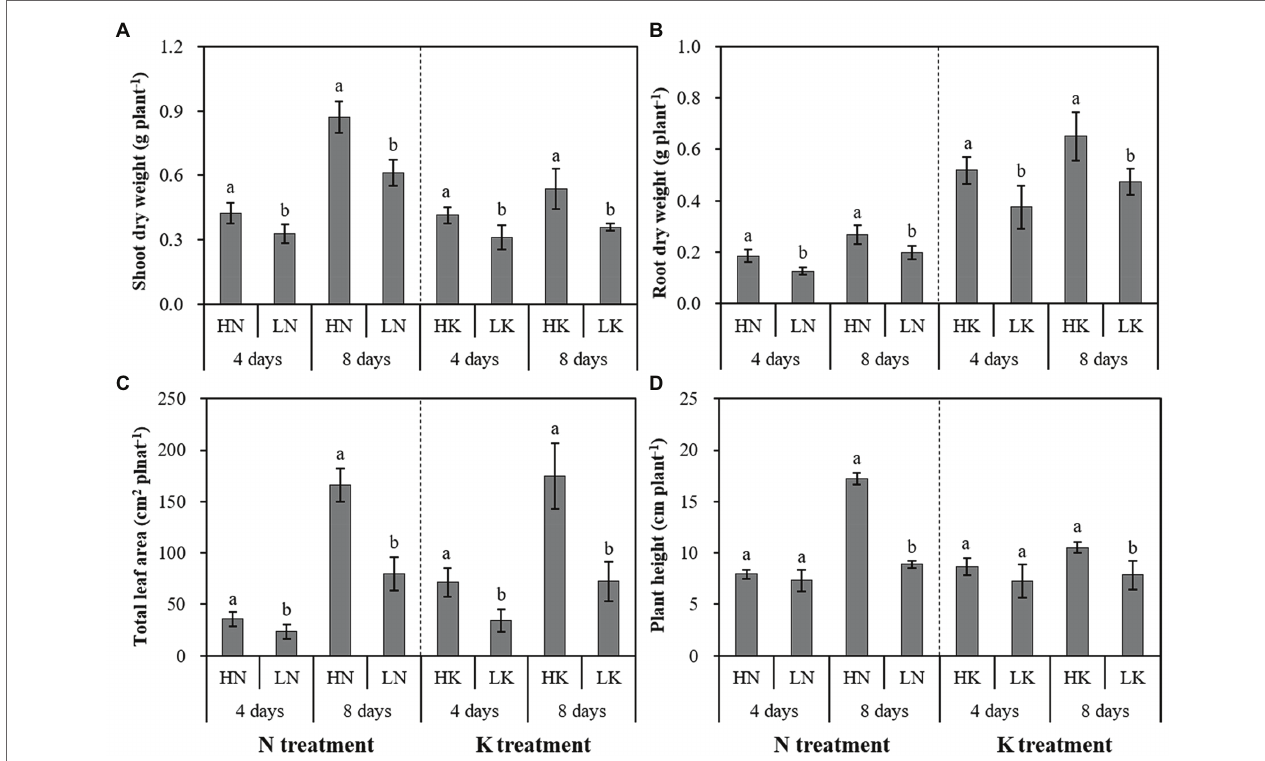
FIGURE 1 | The effect of N deficiency and K deficiency on the shoot dry weight (A) , root dry weight (B) , total leaf area (C) , and plant height (D) of peanut seedlings, respectively. The data are the means ± SDs ( n = 5). The different letters on the bars indicate significant differences between the different N (or K) treatments and the control treatment on the same day according to the LSD test ( p = 0.05). N, nitrogen; K, potassium; and LSD, least significant